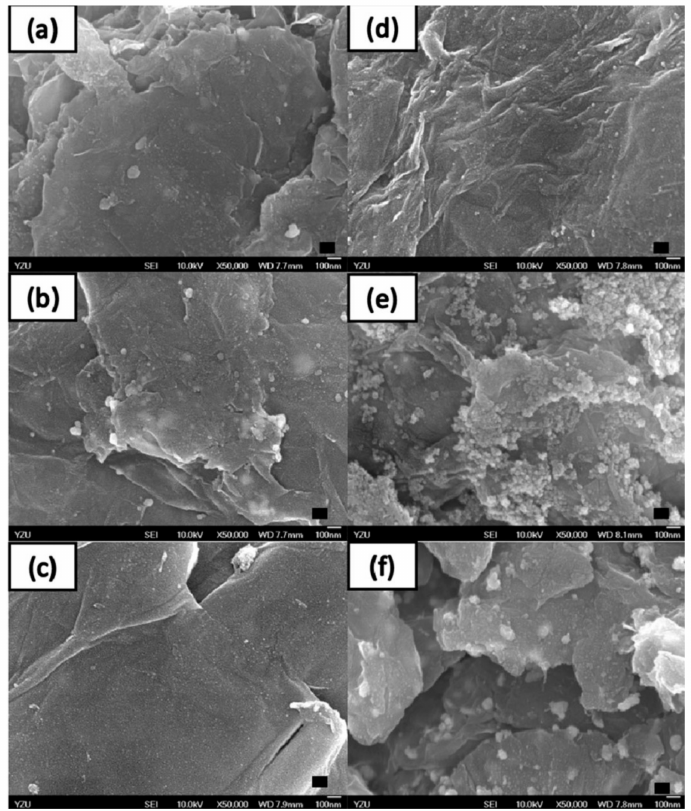
Figure 1. High-resolution scanning electron microscopy. Scanning electron microscopy images of ( a ) 5.34% silver nanoparticle-embedded graphene oxide (Ag / rGO), ( b ) 7.49% Ag / rGO, ( c ) 6.85% zinc oxide nanoparticle-embedded graphene oxide (ZnO / rGO), ( d ) 16.45% ZnO / rGO, ( e ) 3.47% silver nanoparticle, and 34.91% zinc oxide nanoparticle-embedded graphene oxide (Ag / ZnO / rGO), and ( f ) 7.08% silver nanoparticle and 15.28% zinc oxide nanoparticle-embedded graphene oxide (Ag / ZnO / rGO). Black bar is 100 nm. Data are representative of two separate